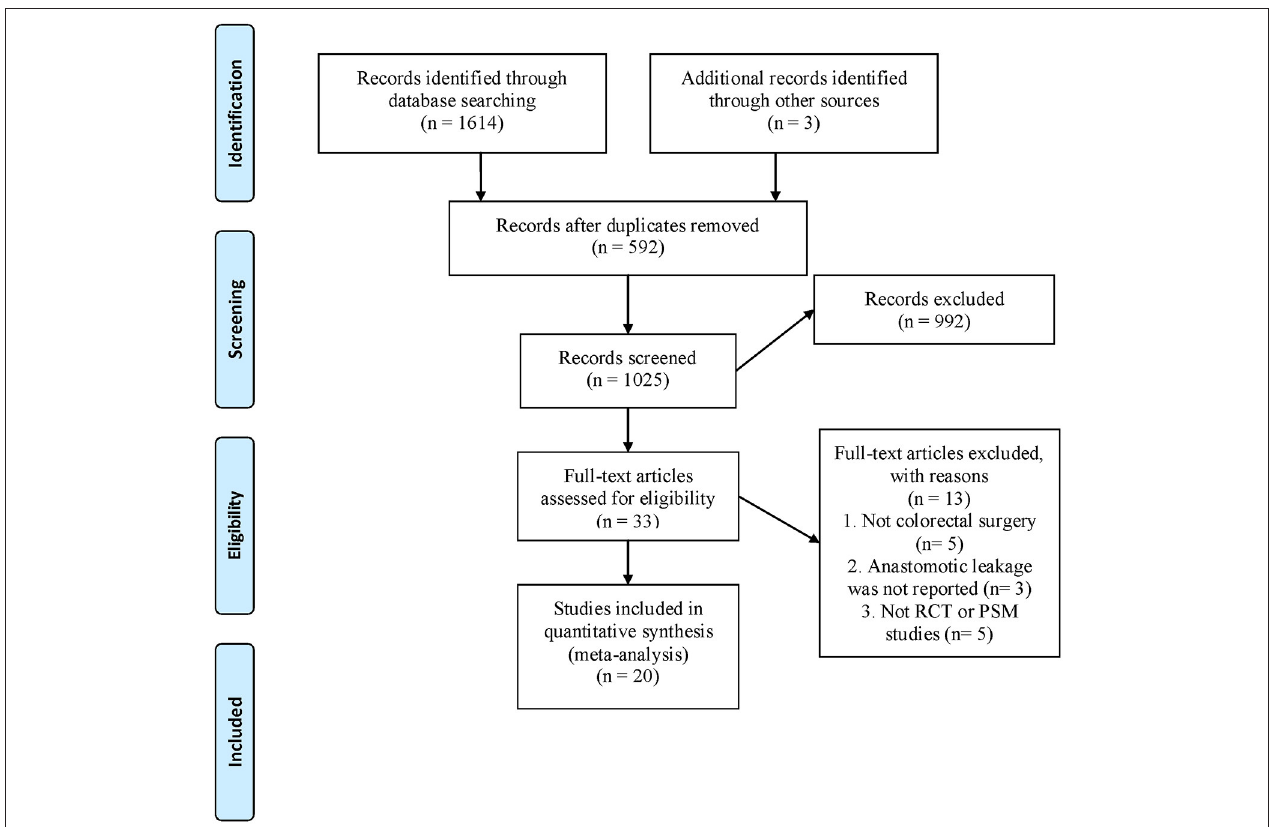
FIGURE 1 | Flow chart of literature search and